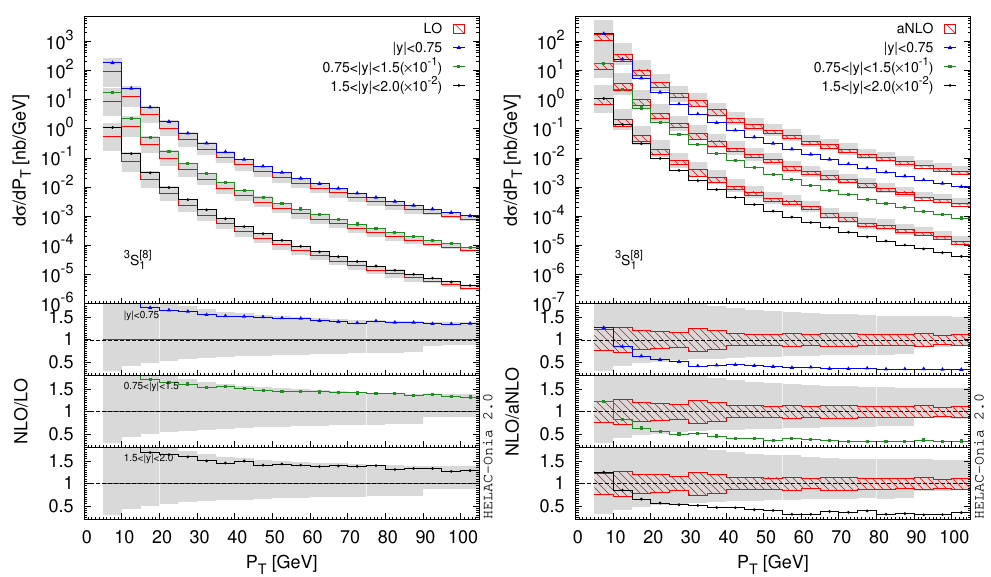
Figure 3 . Comparisons of spin-summed differential cross sections for the Fock state 3 S [8] LO (left), aNLO (right) calculations and the complete NLO